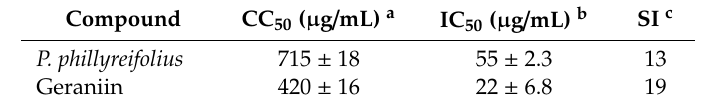
Table 1. Cytotoxicity and antiviral activity of P. phillyreifolius and geraniin against ZIKV.